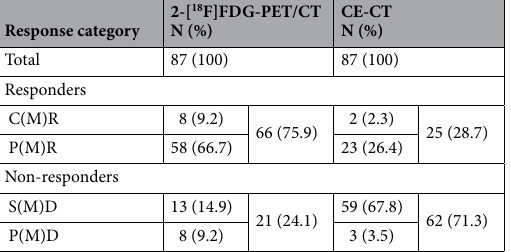
Table 1. Response categorization on CE-CT and 2-[ 18 F]FDG-PET/CT for the first follow-up scan in